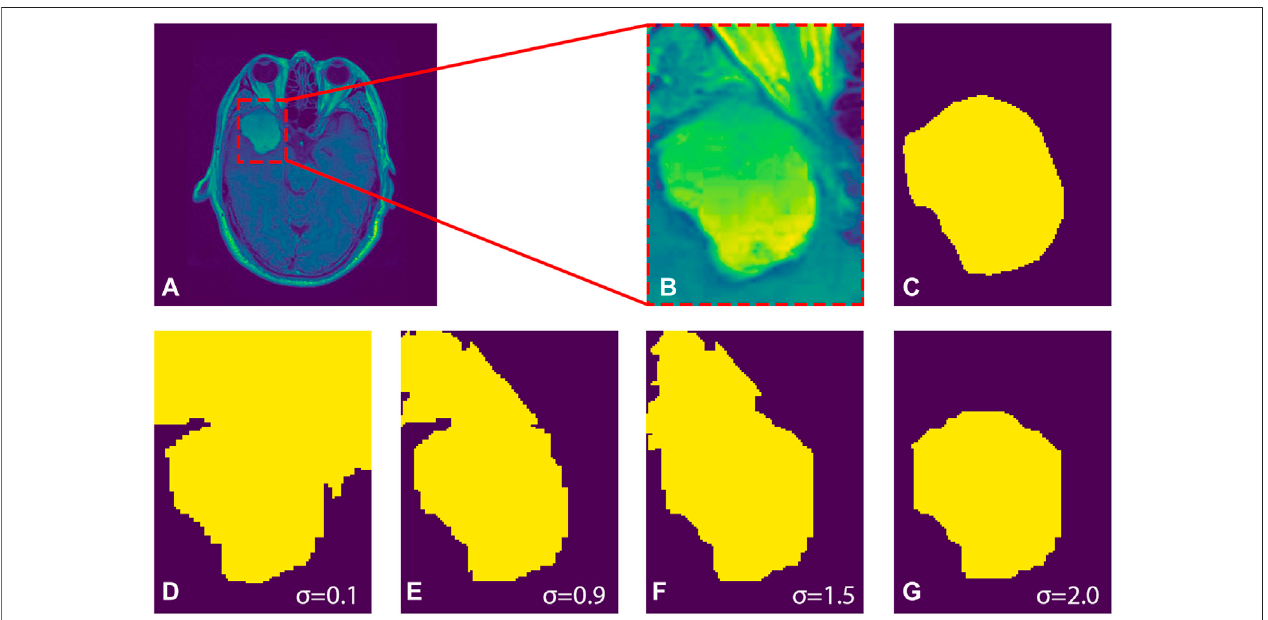
FIGURE 6 | Segmenting the tumor interactively without tuning parameters. (A – E) Segmenting the brain tumor interactively when sigma = 0.1. (F) Visualized labels of the segmented tumor and the background.